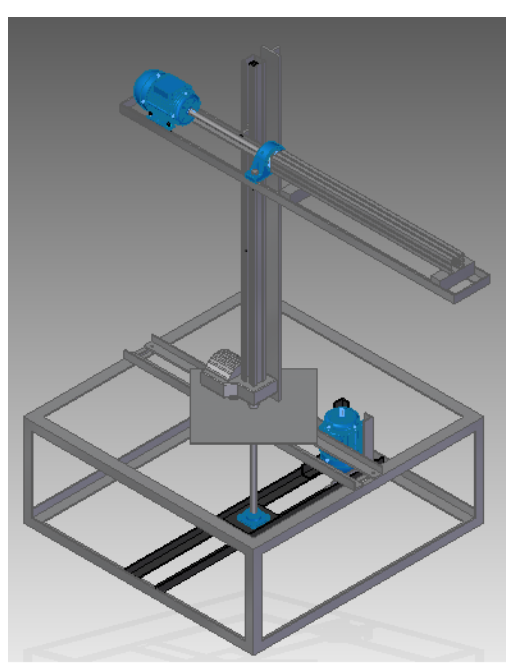
Figure 1. Setup of cylindrical manipulator.